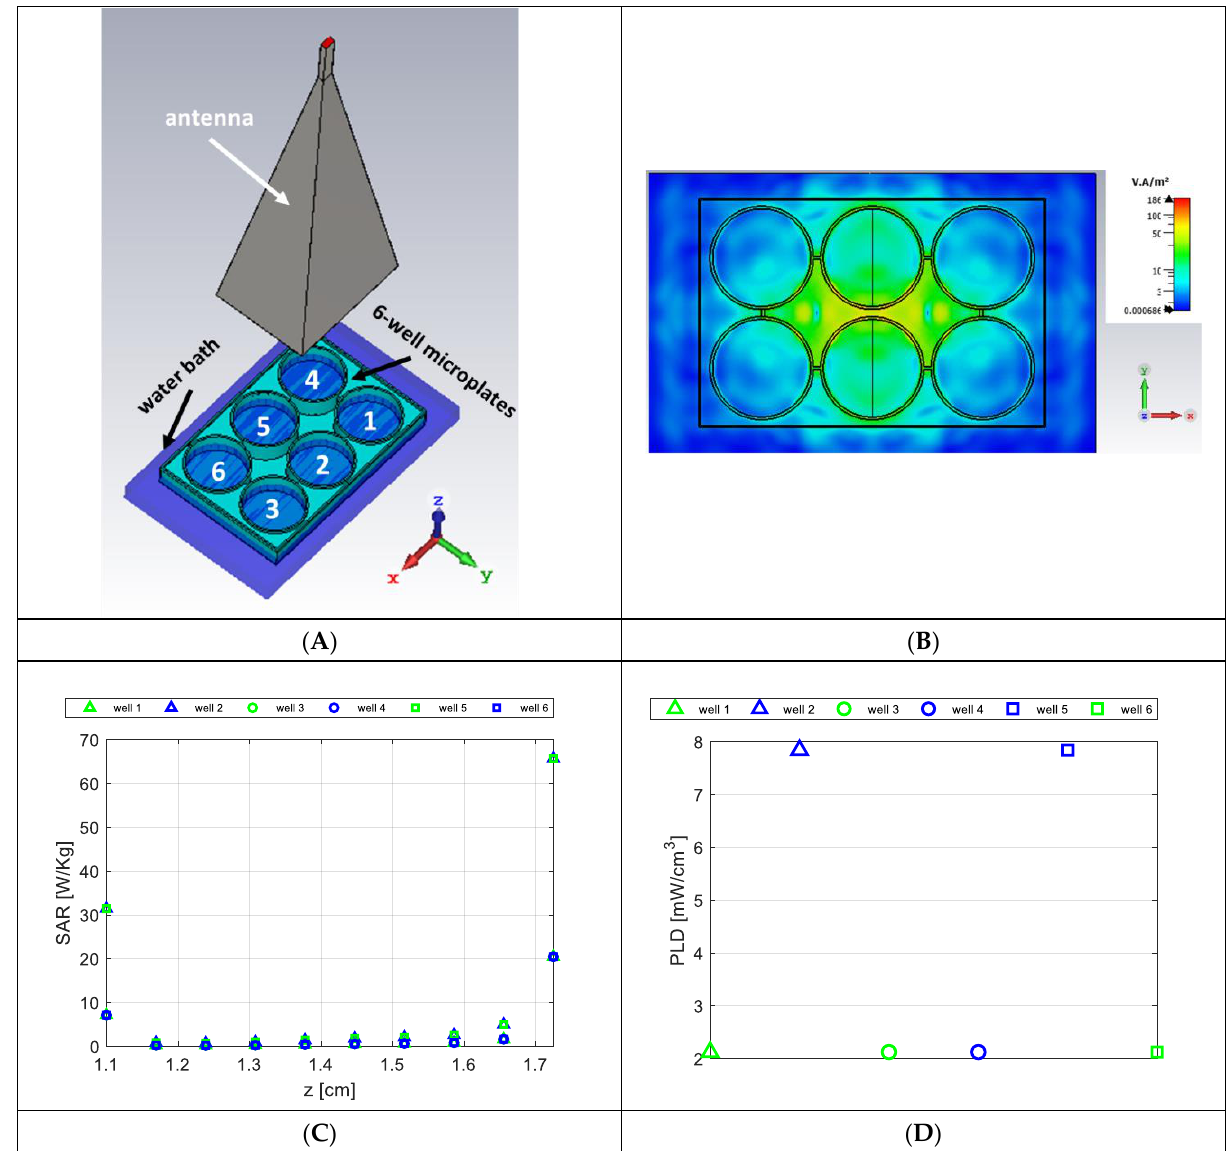
Figure 1. Experimental setup for numerical dosimetry. ( A ) CAD model (six-well microplates num- bered for understanding the following figures); ( B ) Incident power density at the water sample-air interface; ( C ) Average point SAR for each aqueous sample in the well; ( D ) Average PLD for each aqueous sample in the wells.